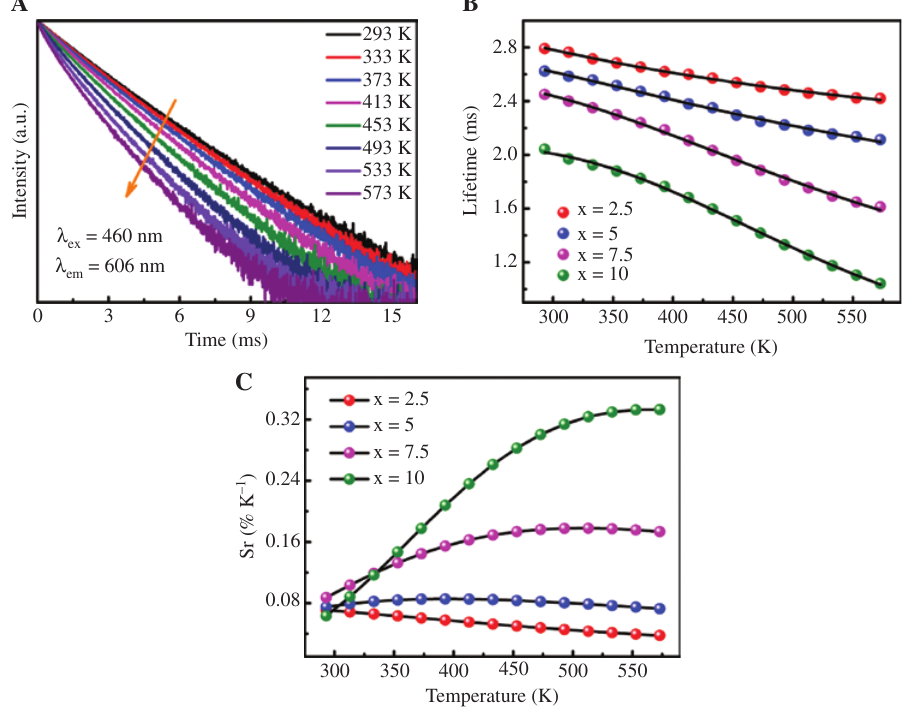
Figure 8: The measurement results for the lifetime-based temperature sensing. (A) Temperature-dependent PL decay curves of the 5 D temperature for samples with different concentrations. (C) Temperature dependence of S